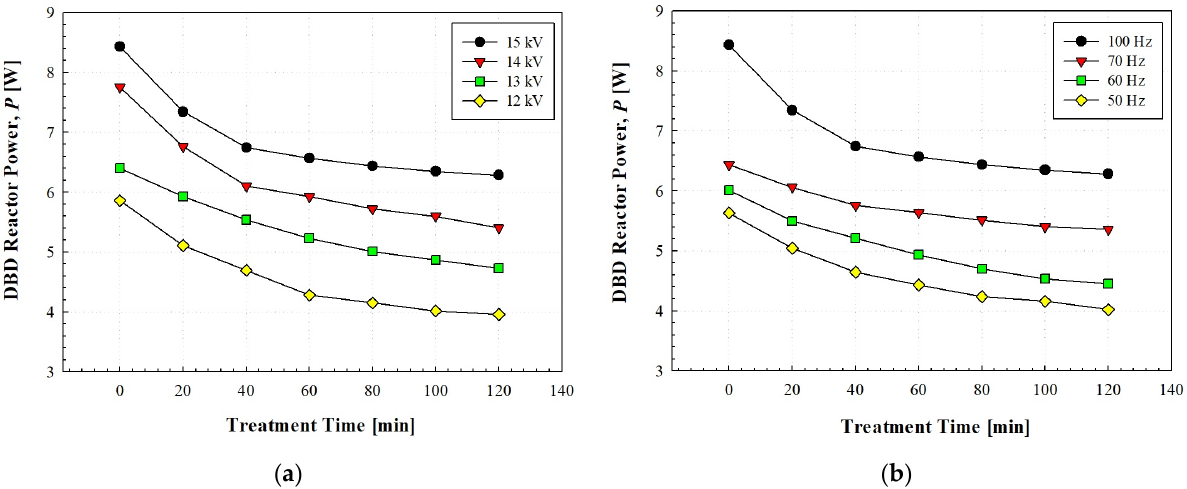
Figure 10. ( a ) P-treatment time graph based on the voltage at 100 Hz ( b ) P-treatment time graph based on the frequency at 15 kV.